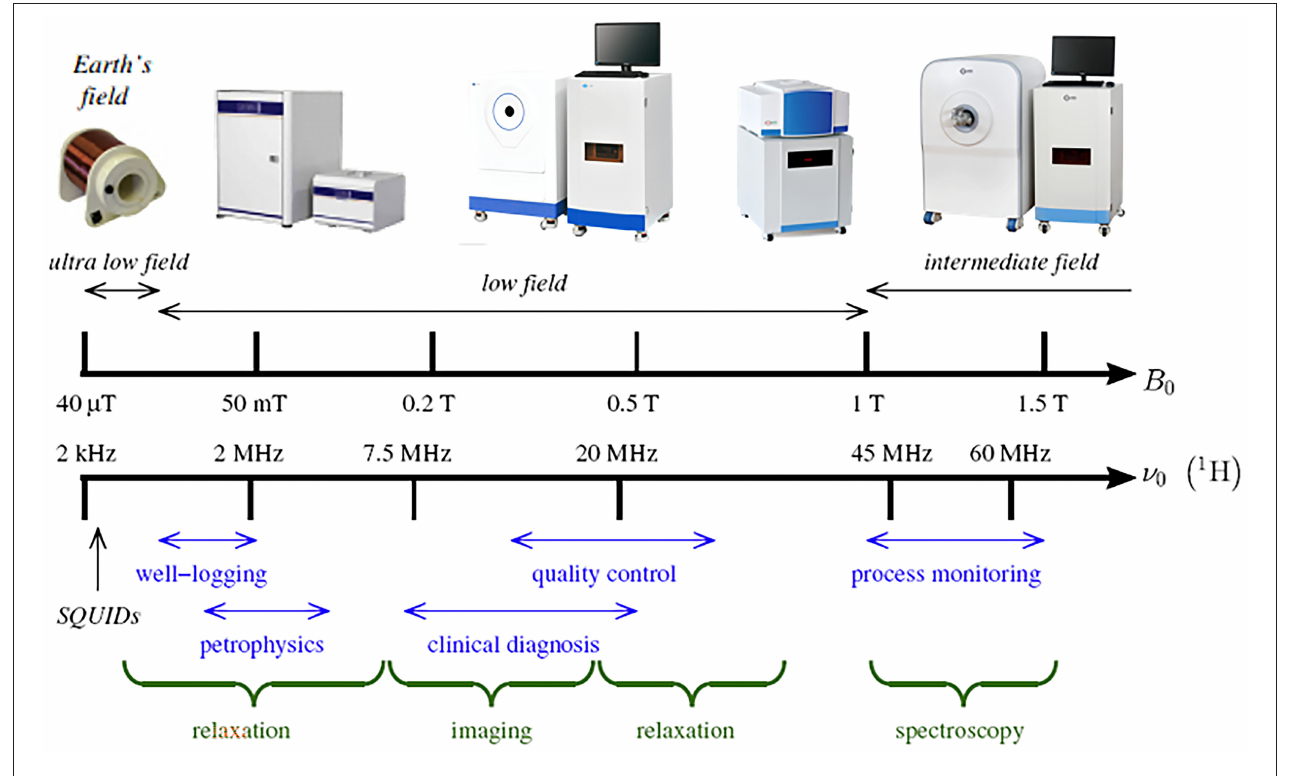
FIGURE 1 | Schematic illustration of the strength of the magnetic field.